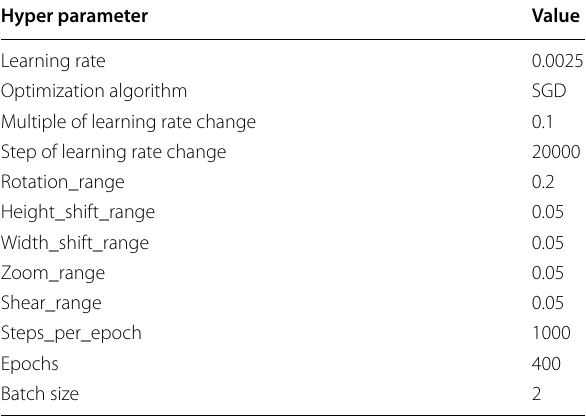
Table 1 Hyper parameters of all used neural